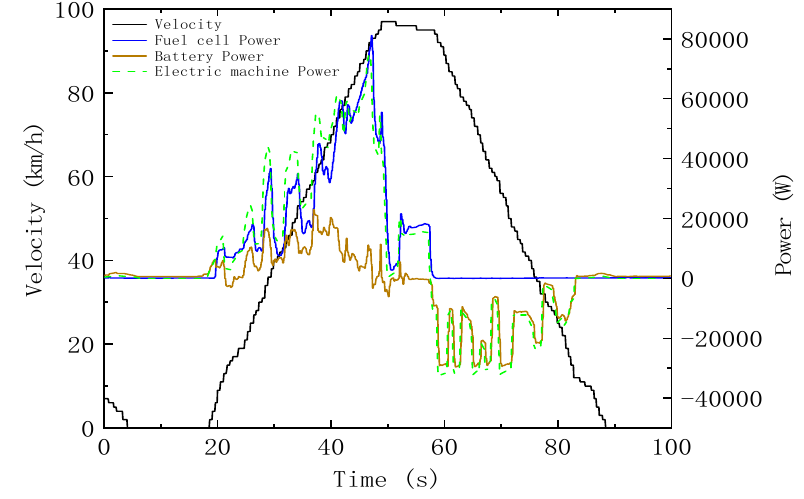
Figure 17. Changes in power of main components of FCHEV during 0–100 km / h acceleration.